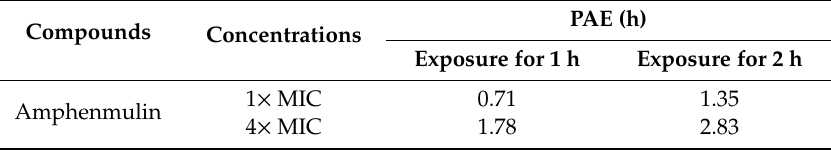
Figure 3. The bacterial growth kinetic curves for MRSA ATCC 43300 exposed to amphenmulin for 1 h ( A ) or 2 h ( B ). Table 2. The PAE values of amphenmulin against MRSA ATCC 43300.